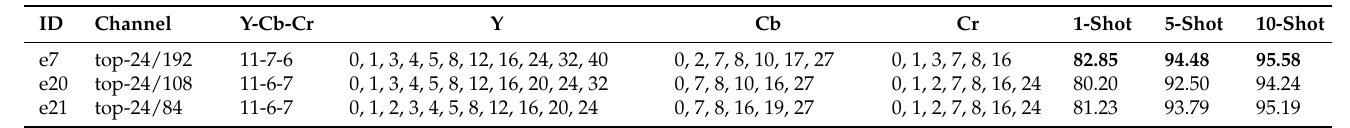
Table 4. The results of top-24 channels selected from different ranges. ( f θ : Resnet12; method: f; data: setting-2; filter-size: 8 × 8).